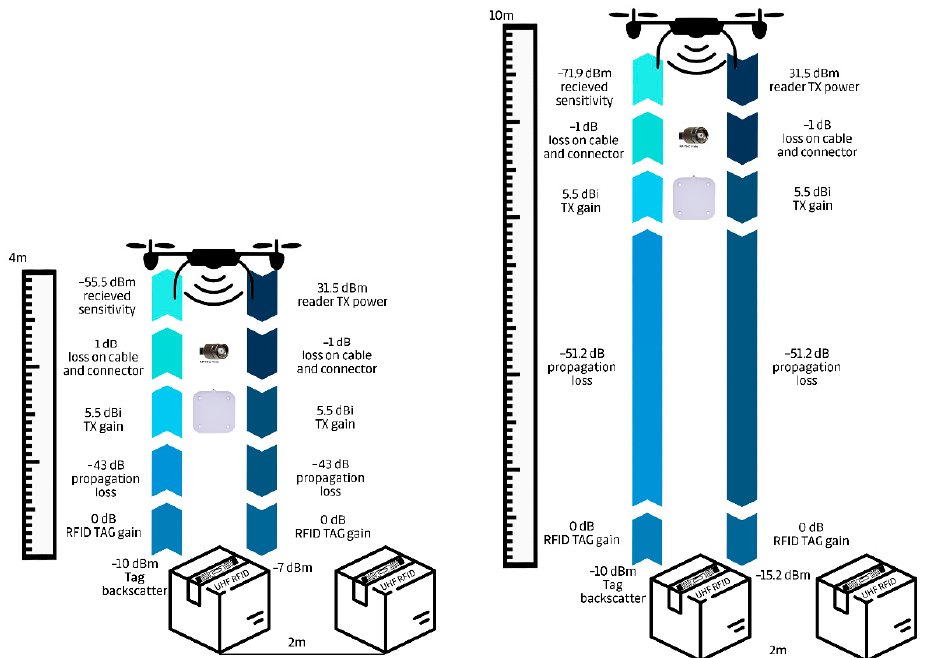
Figure 1. Signal propagation in free space, different reading distances.